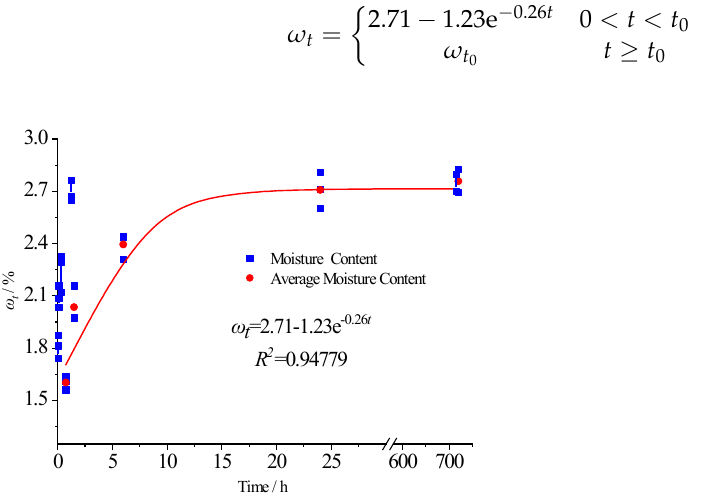
Figure 3. The correlation between water content and soaking time.